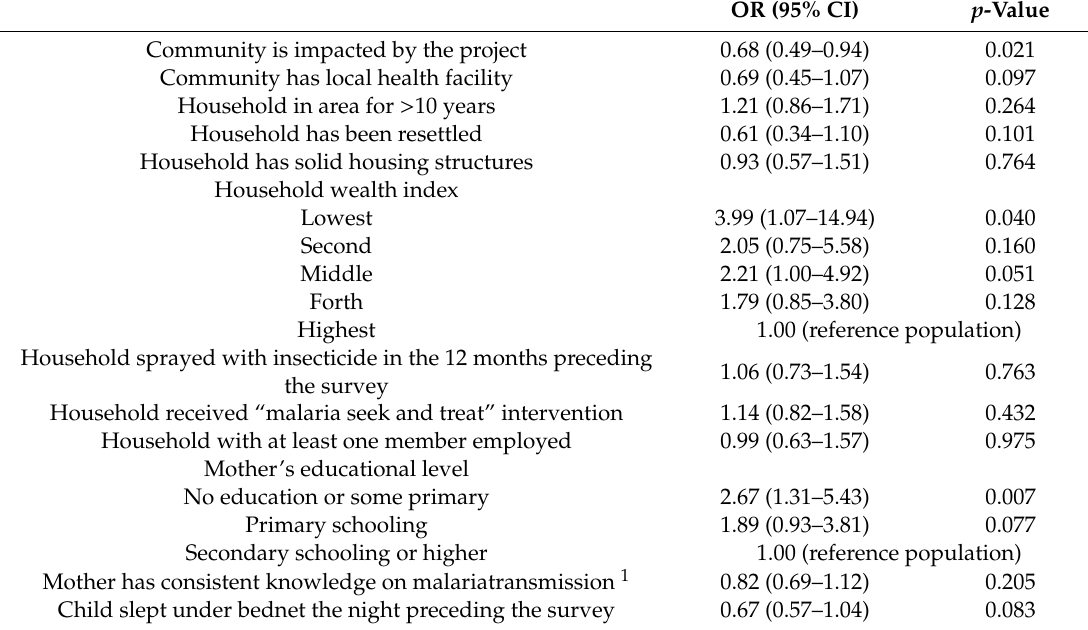
Table 3. Logistic regression model comparing P. falciparum prevalence in children aged 6–59 months in impacted vs. non-impacted comparison communities with inclusion of secondary predictors, Trident project, Zambia (2011, 2015 and